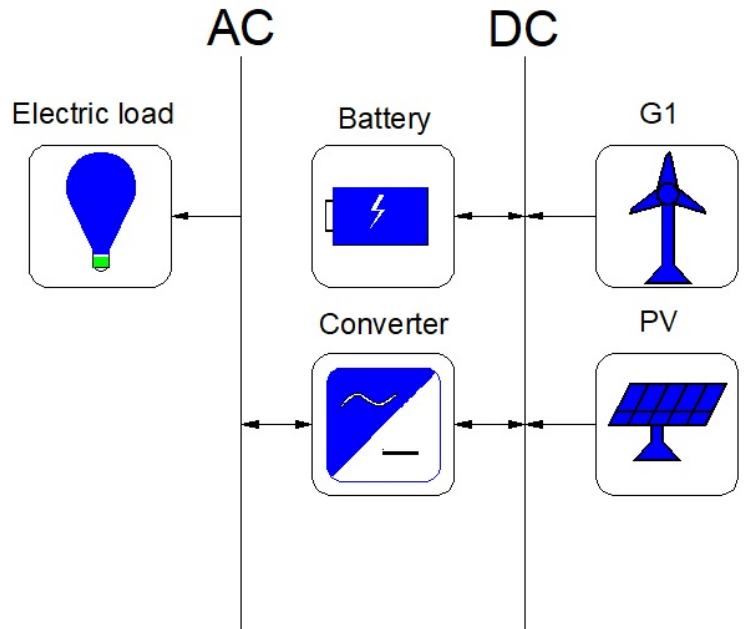
Figure 2. Hybrid off ‐ grid system scheme.